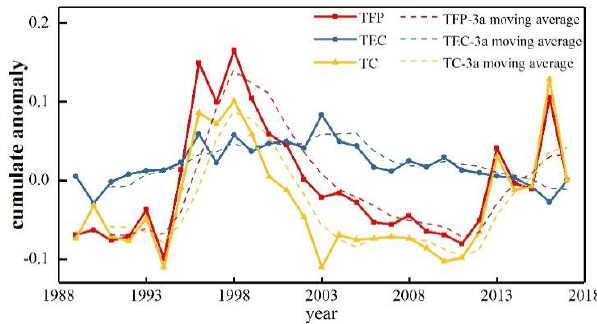
Figure 2. The trend of the cumulative anomaly of agricultural TFP , TEC , and TC with time in Gansu Province.